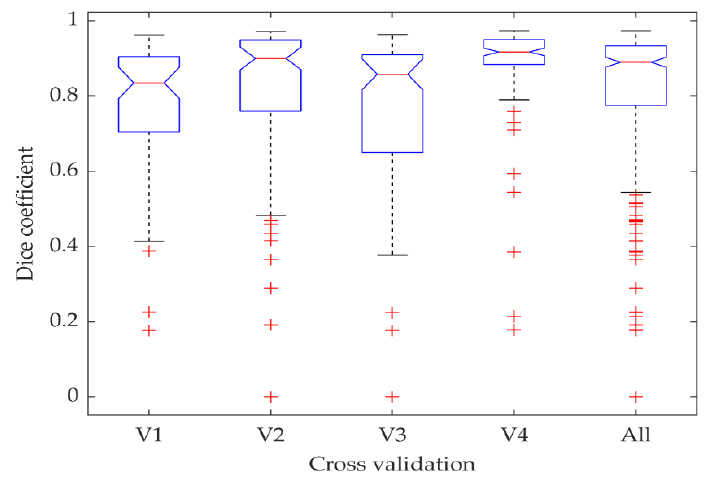
Figure 10. Statistics of the Dice coefficient computed for different cross-validation folds visualized using boxplots.